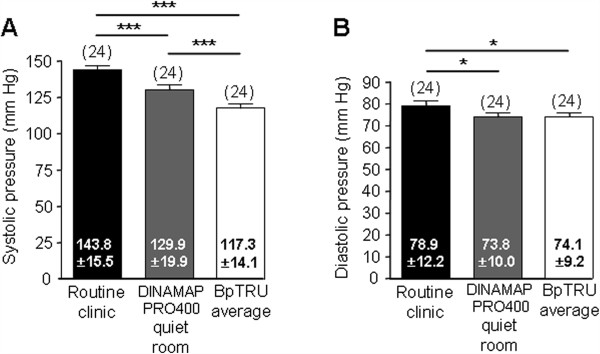
Comparison between DINAMAP PRO400 and BpTRU measurements. A. Bar graph showing comparison between routine clinic systolic BP, systolic BP measured with the DINAMAP PRO400 monitor in a quiet room, and systolic BP recorded with BpTRU. ANOVA (repeated measures) showed a significant overall difference (P < 0.0001); Bonferroni’s multiple comparison post hoc test showed that the routine clinic reading was significantly higher than both the reading with the DINAMAP PRO400 monitor in the quiet room (P < 0.001) and the BpTRU reading (P < 0.001). The BpTRU reading was also significantly lower than the reading with a DINAMAP PRO400 monitor in the quiet room (P < 0.001). B. Bar graph showing comparison between mean diastolic BP values, measured as described in A. ANOVA (repeated measures) showed a significant overall difference (P = 0.0073); Bonferroni’s multiple comparison post hoc test showed that the routine clinic reading was significantly higher than both the reading taken with the DINAMAP PRO400 monitor in a quiet room (P < 0.05) and the reading taken with BpTRU (P < 0.05).